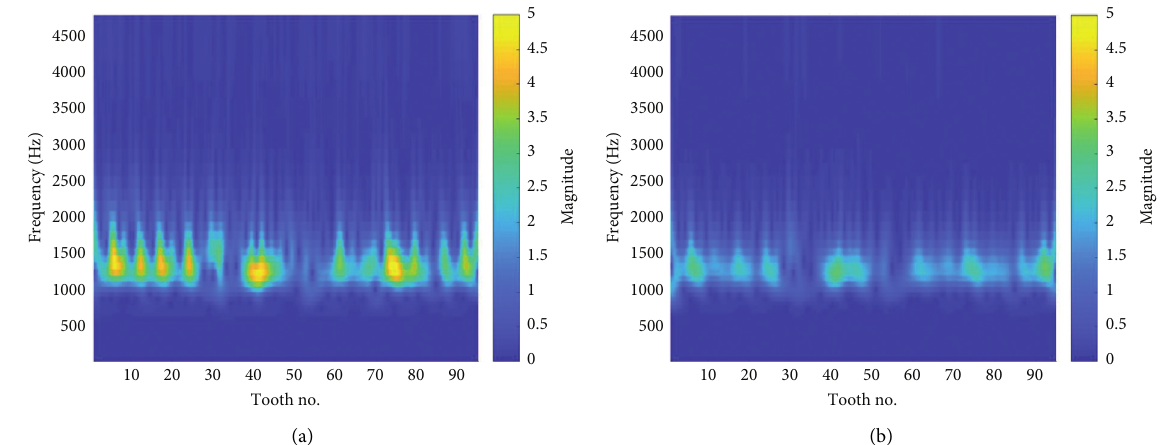
Figure 7: Wavelet analysis: (a) 50 hours and (b) 100 hours of experiment.